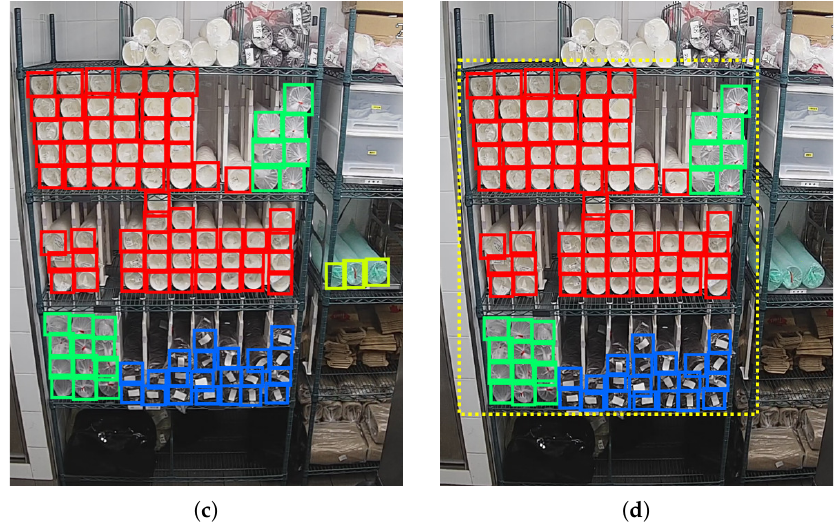
Figure 13. Detection results comparison of setting detection area. ( a , c ) Detection results before setting detection area. ( b , d ) Detection results after setting detection area.